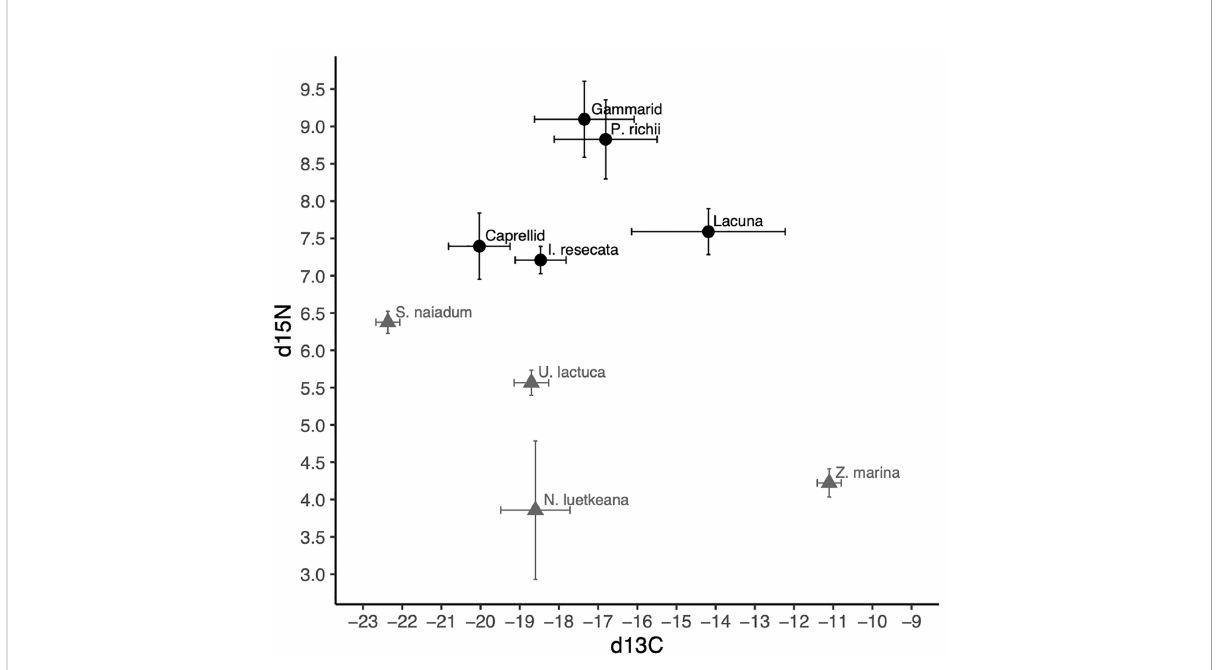
FIGURE 3 d 13 C and d 15 N signatures (mean and standard deviation) of invertebrate mesograzers (black) and macrophytes (grey) in the Choked Pass Z. marina